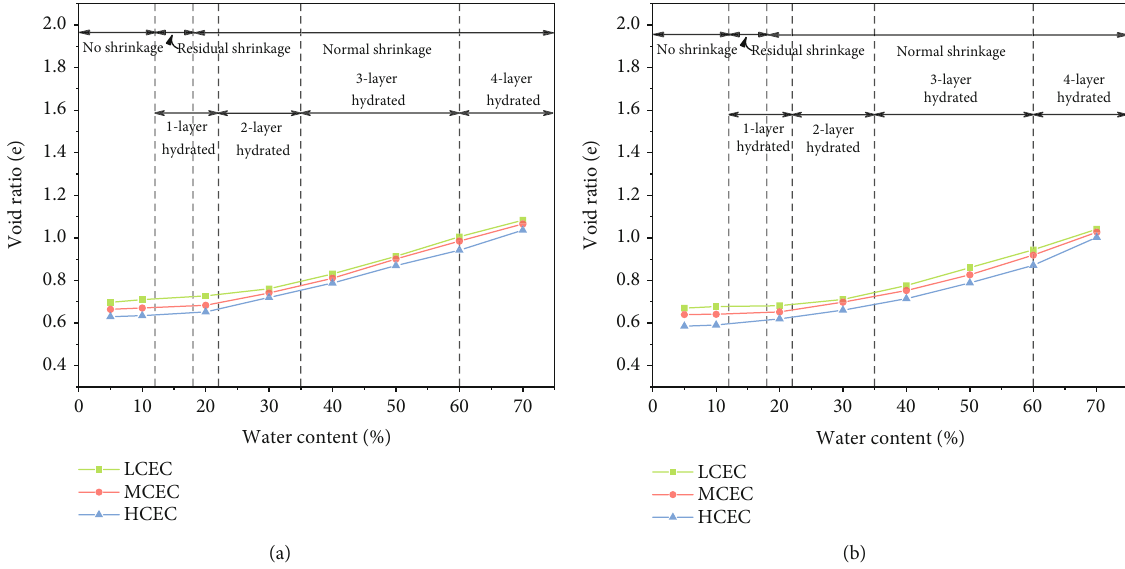
Figure 4: Nanoscale shrinkage curve of Mnt: (a) Na-Mnt and (b)